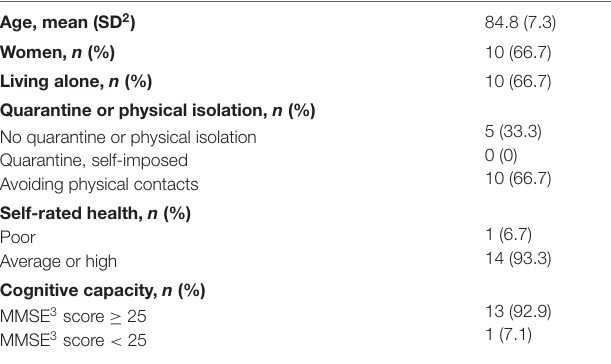
TABLE 1 | Characteristics of the participants in the Cardiovascular Risk Factors, Aging, and Dementia (CAIDE) 85 + 1 COVID-19 qualitative in-depth interviews ( n =